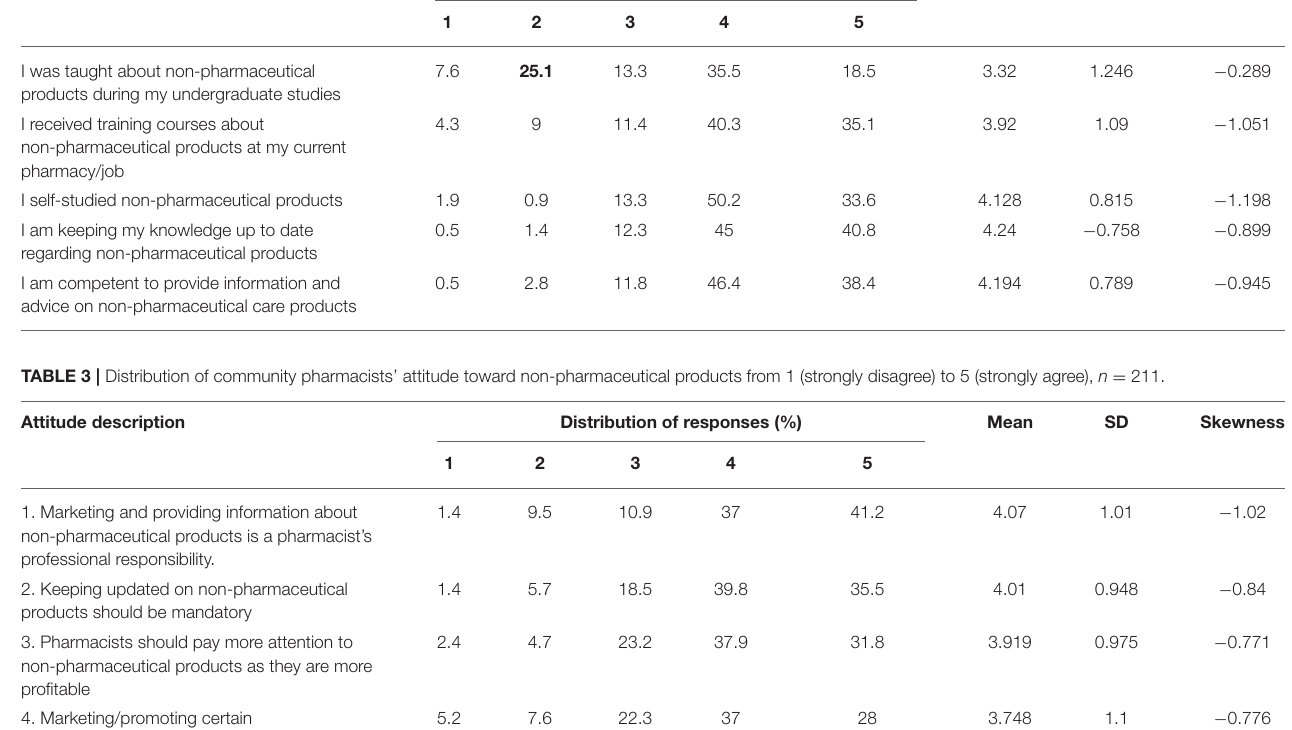
TABLE 2 | Distribution of community pharmacists’ prior knowledge and training toward nonpharmaceutical products from 1 (strongly disagree) to 5 (strongly agree), n = 211. Knowledge description